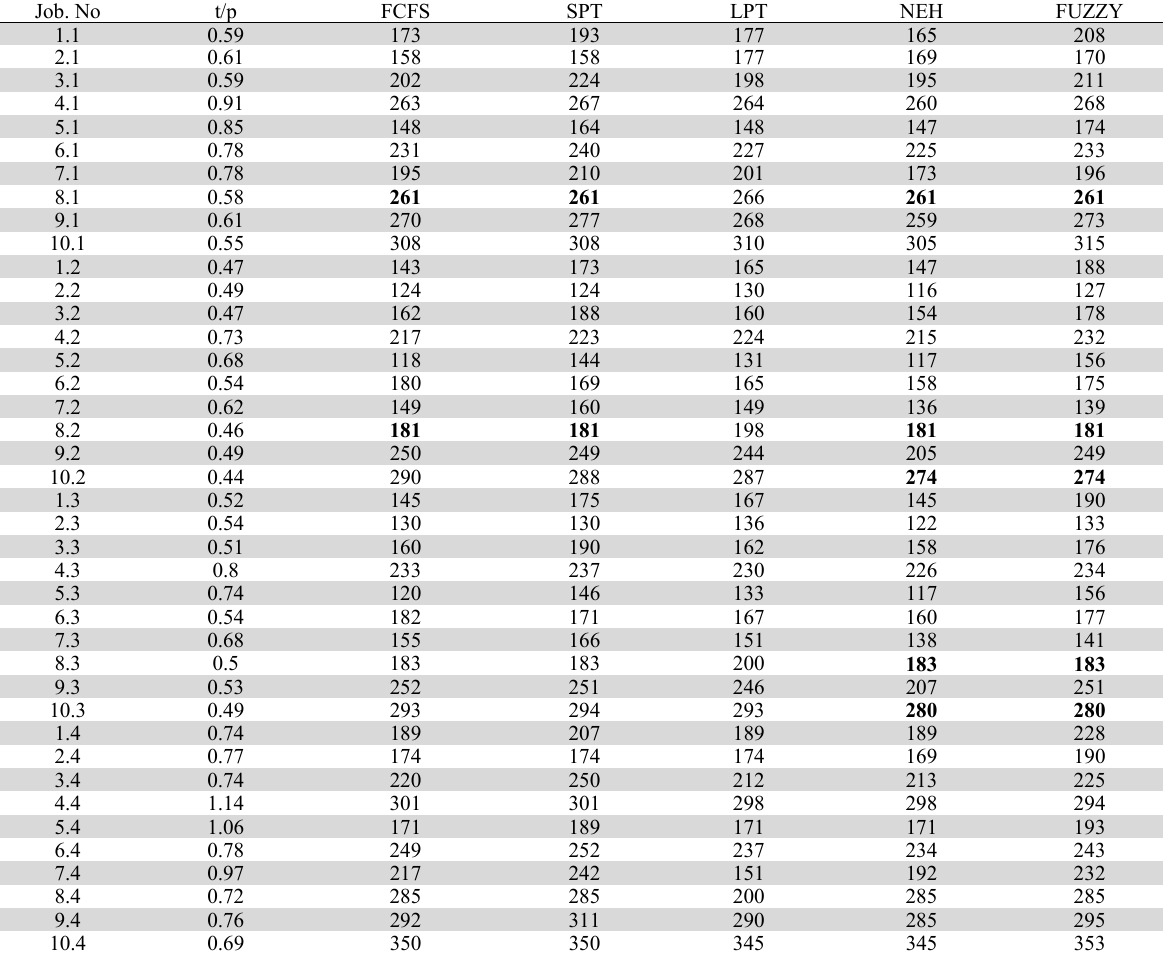
Comparison of make span values with